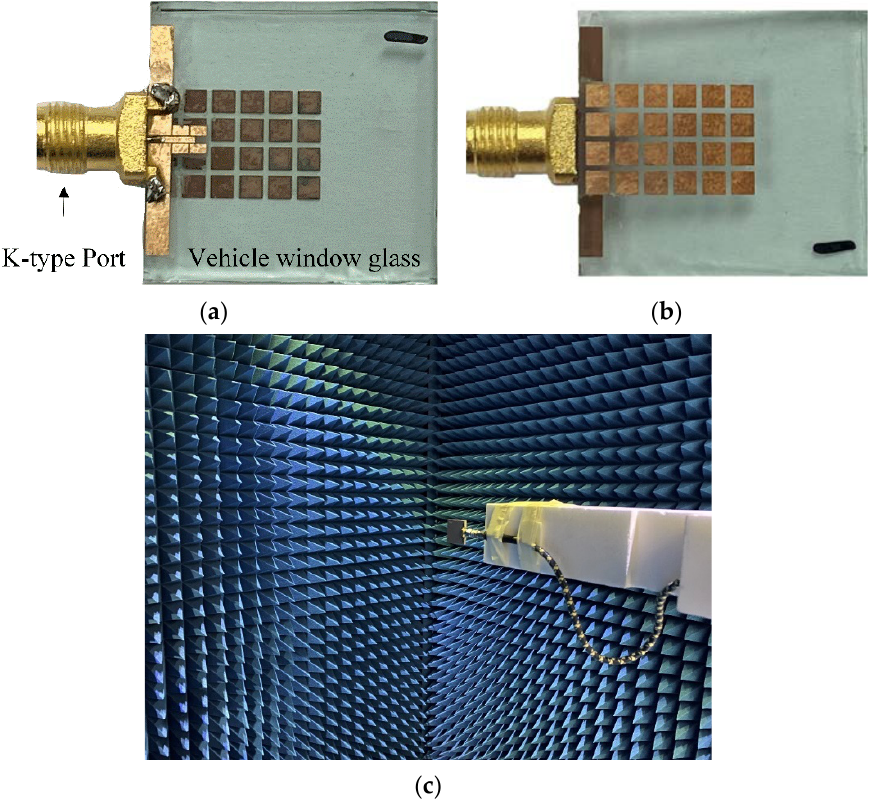
Figure 3. Photographs of the proposed antenna and measurement setup: ( a ) top view; ( b ) bottom view; ( c ) measurement setup.